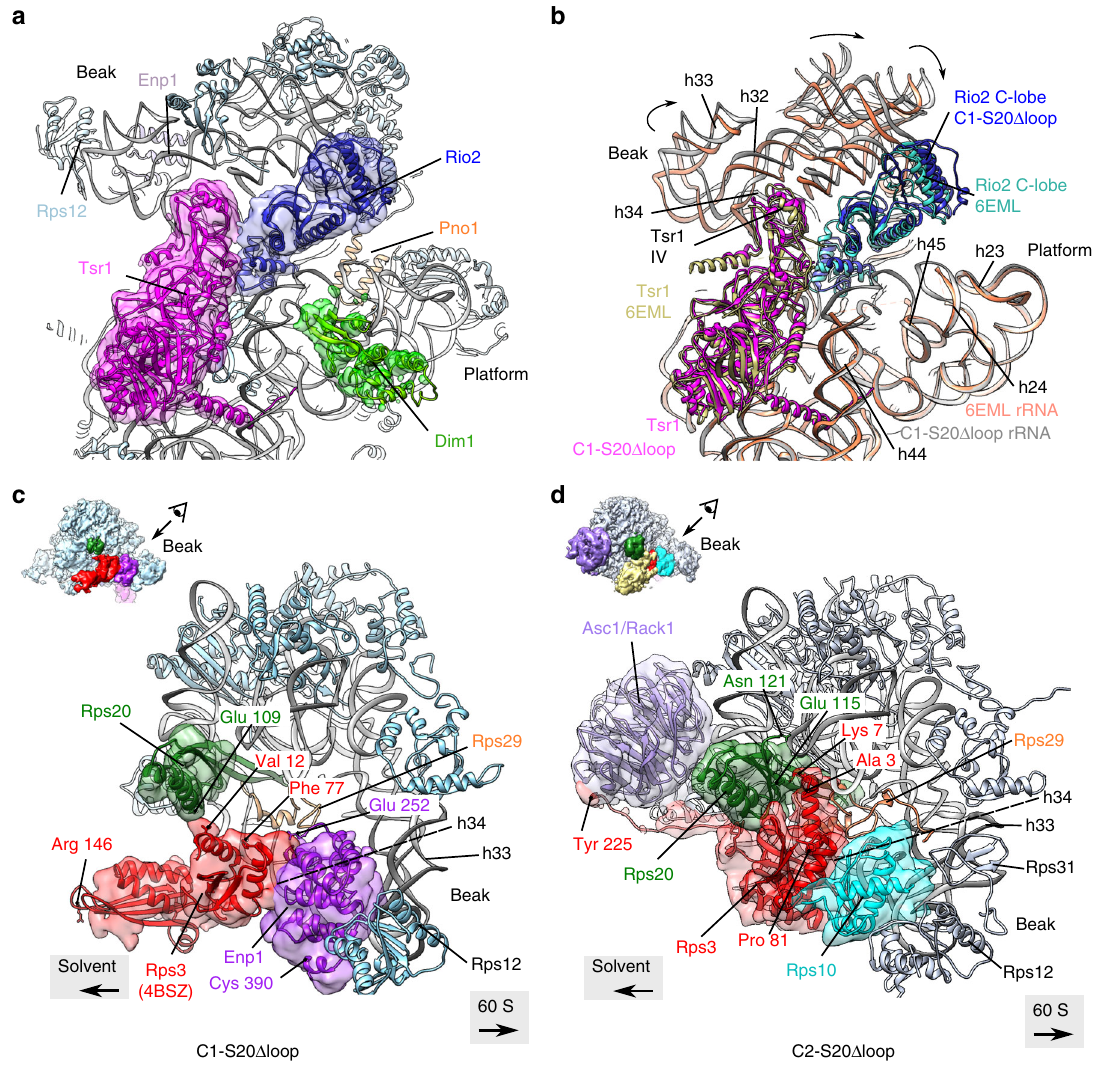
Fig. 6 Structural details of C1-S20 Δ loop and C2-S20 Δ loop pre-40S particles. a Close-up of the atomic model of C1-S20 Δ loop, as seen from the 60S interface; segmented cryo-electron microscopic (cryo-EM) densities corresponding to Tsr1, Rio2, and Dim1 are shown in magenta, blue, and lime green, respectively. rRNA is in gray, and other r-proteins in pale blue. b Same view of the C1-S20 Δ loop model as in a , superimposed to the model of pre-40S particles puri fi ed with Ltv1 as bait (PDB 6EML) 16 . Spatial alignment was realized using the Matchmaker option in Chimera, using C1-S20 Δ loop rRNA as reference. For more clarity, only Tsr1, Rio2, and rRNA of both models are displayed. Color codes are indicated on the panel. Arrows indicate the rotation of the head of C1-S20 Δ loop particles compared to the PDB 6EML model. c , d Close-up of the heads of C1-S20 Δ loop ( c ) and C2-S20 Δ loop pre-40S particles ( d ), as seen from the top of the head/beak of the particles (top-left insets indicate direction of view). Segmented cryo-EM densities corresponding to Rps20, Rps3, Enp1, Asc1, and Rps10 are represented in green, red, purple, pale violet, and turquoise, respectively. rRNA is in gray, and other r-proteins